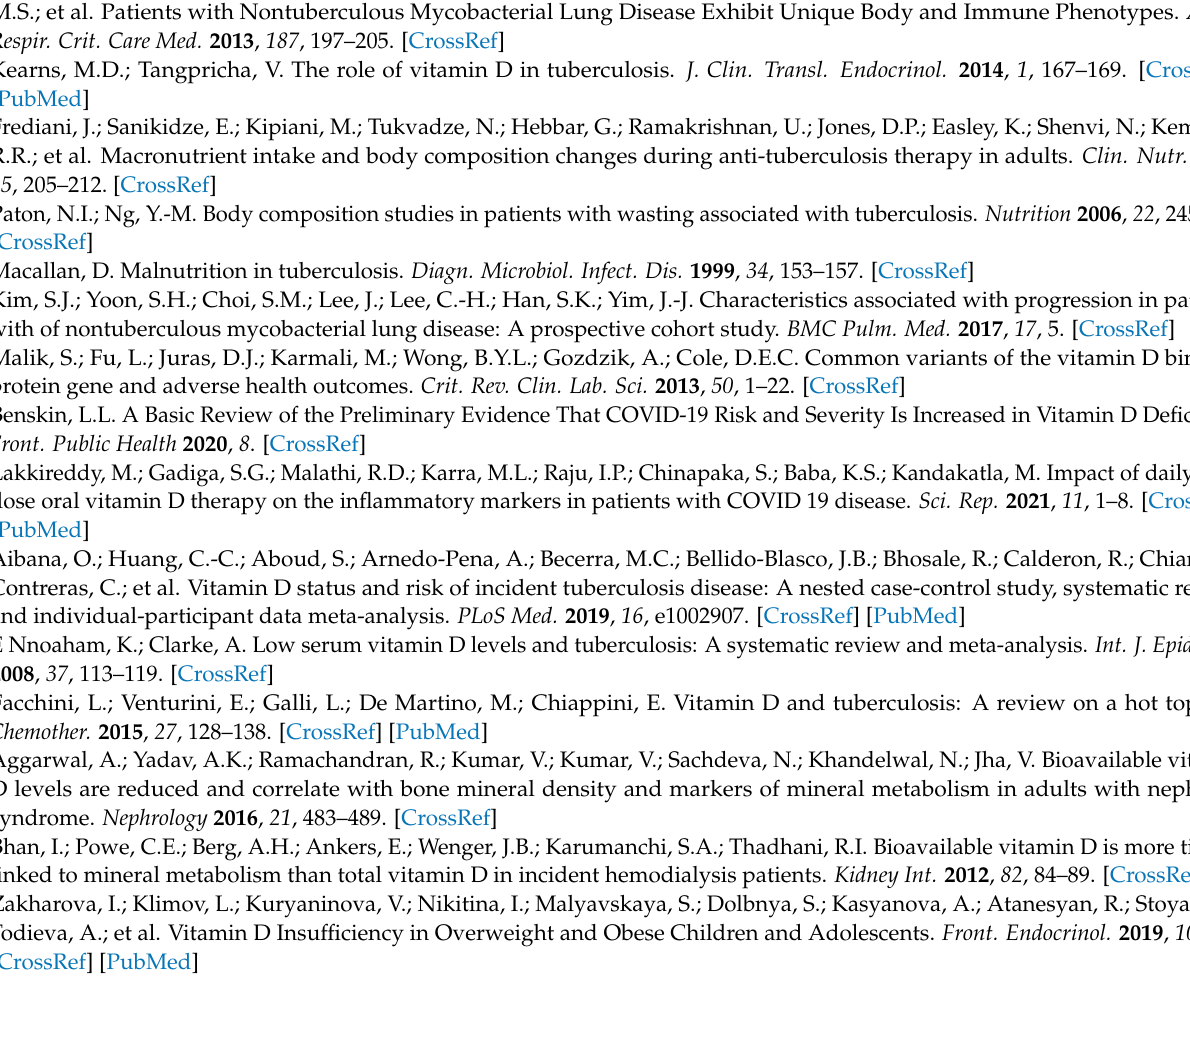
Table S3: Risk factors associated with NTM-PD; Table S4: Vitamin D parameters in patients with NTM-PD according to the treatment